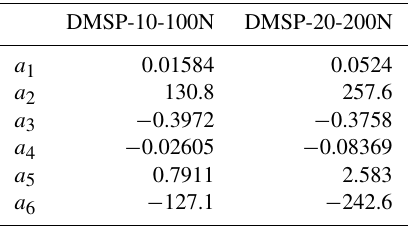
Table 2. Coefficients of Eq. (1) for approximating the static char- acteristics of commercial FESTO McKibben